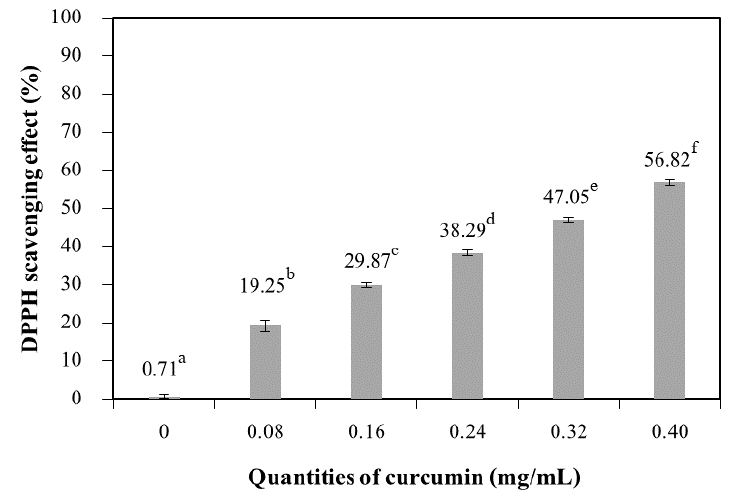
Figure 10. DPPH scavenging effect of chitosan film incorporated with various curcumin quantities. Results marked with different letters are statistically different ( p < 0.05).